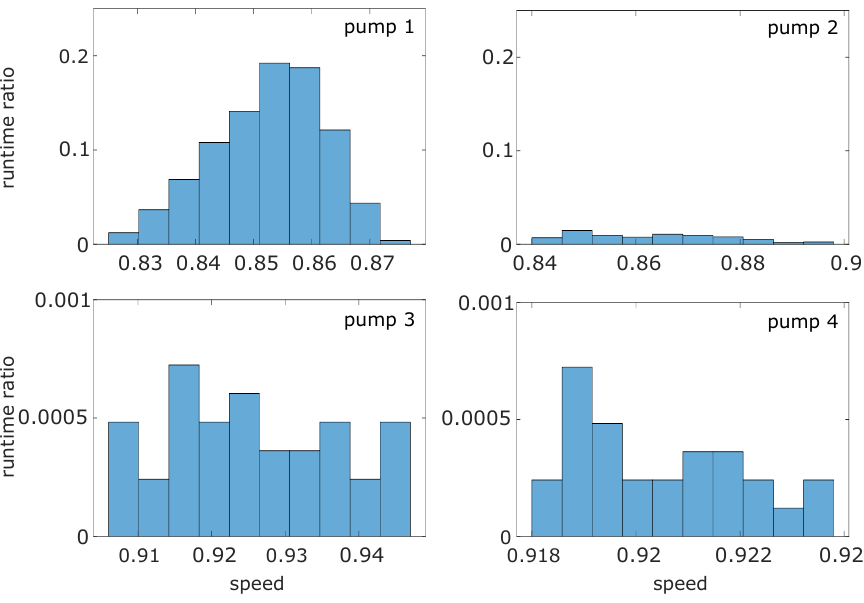
Figure 10. Pump operation statistics for the year